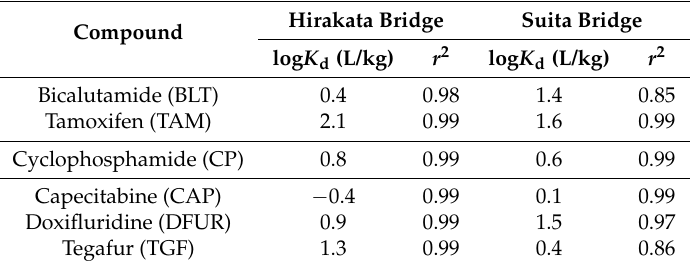
Figure 2. Distribution of the target anticancer drugs in the river sediments and suspended solids (abbreviation of each anticancer drug is shown in Table 1) (reproduced from [31]). Table 6. Sorption distribution coefficients (log K d ) of anticancer drugs for river sediments in sorption experiments (reproduced from